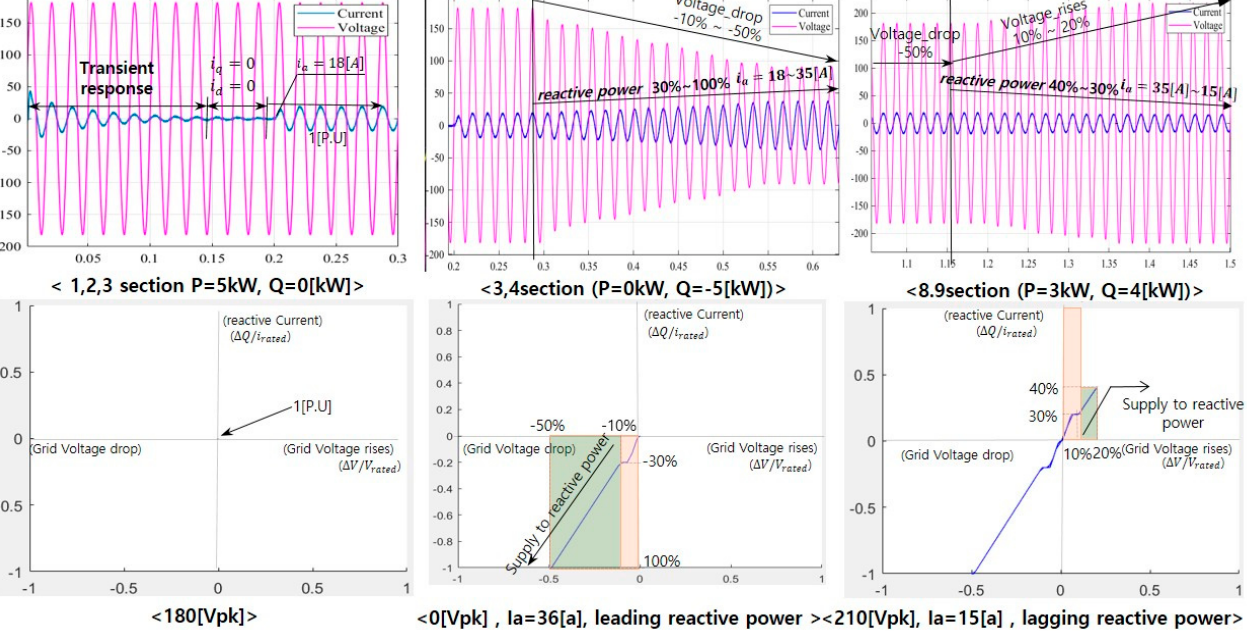
Figure 19. Comparison of dynamic grid support and simulation test results for each section.